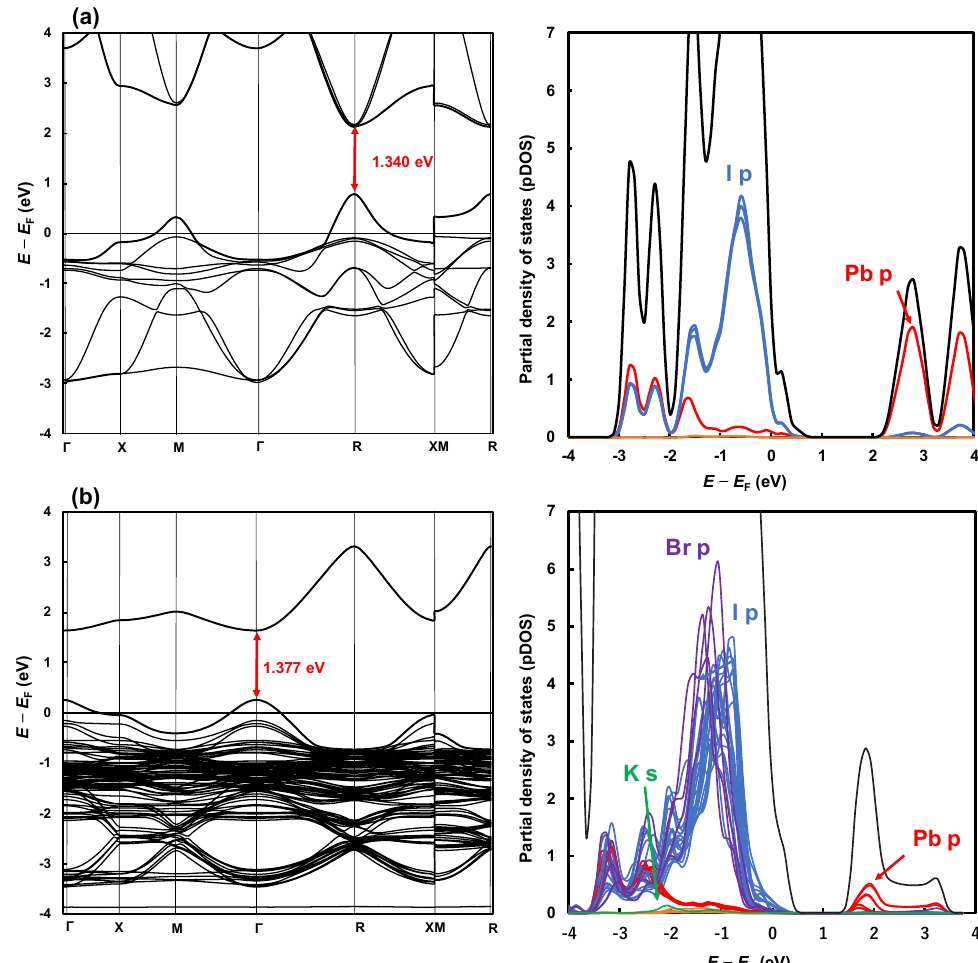
Figure 7. Band structures and density of states of ( a ) MAPbI 3 and ( b ) MA 0.625 EA 0.25 K 0.125 PbI 2.5 Br 0.5 . Table 3. Calculated energy gaps and difference of total energies.